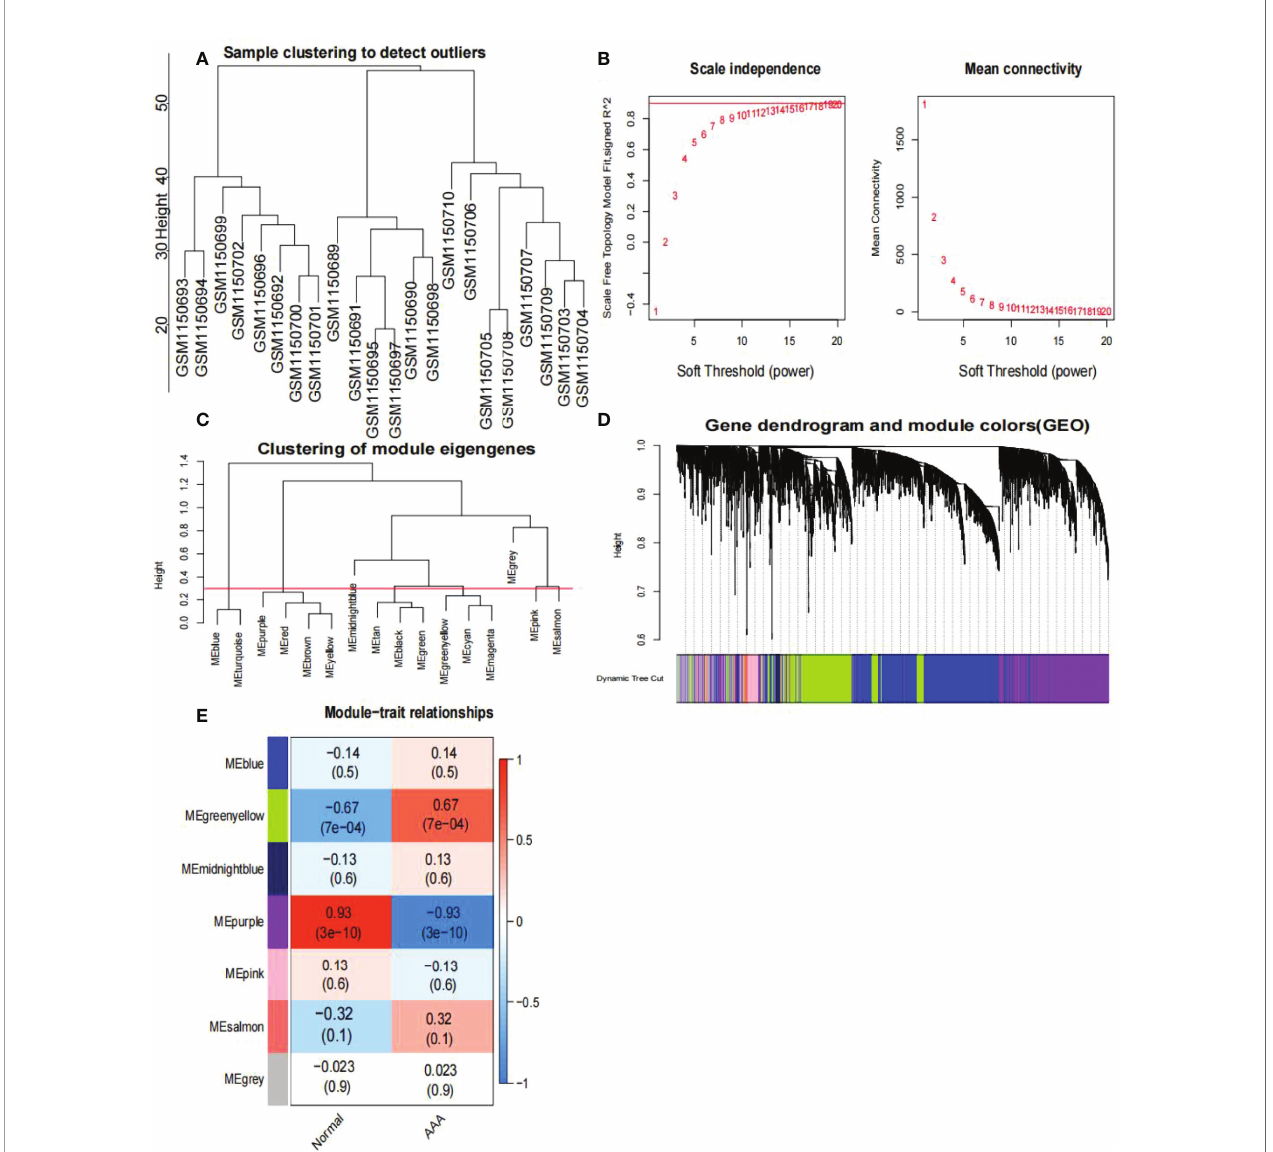
FIGURE 4 | Analysis of the weighted co-expression network in GSE47472. (A) Sample clustering of dataset GSE47472. The samples were classi fi ed into three clusters that were signi fi cantly distinct. All clusters were chosen for further analysis. (B) Selection of optimal thresholds. The threshold is 19. (C) Set the threshold to 0.3 to merge modules that are comparable in the cluster tree. (D) Different modules are produced and shown in different colors by aggregating genes with strong correlations into a same module. Blue modules make up a greater proportion. (E) Analysis of correlations between modules and AAA. The green-yellow module was signi fi cantly correlated with AAA (COR = 0.67, P < 0.001) and with normal samples (COR = -0.67, P < 0.001). The WGCNA-hub genes were provided to the genes in the green-yellow module. AAA, abdominal aortic